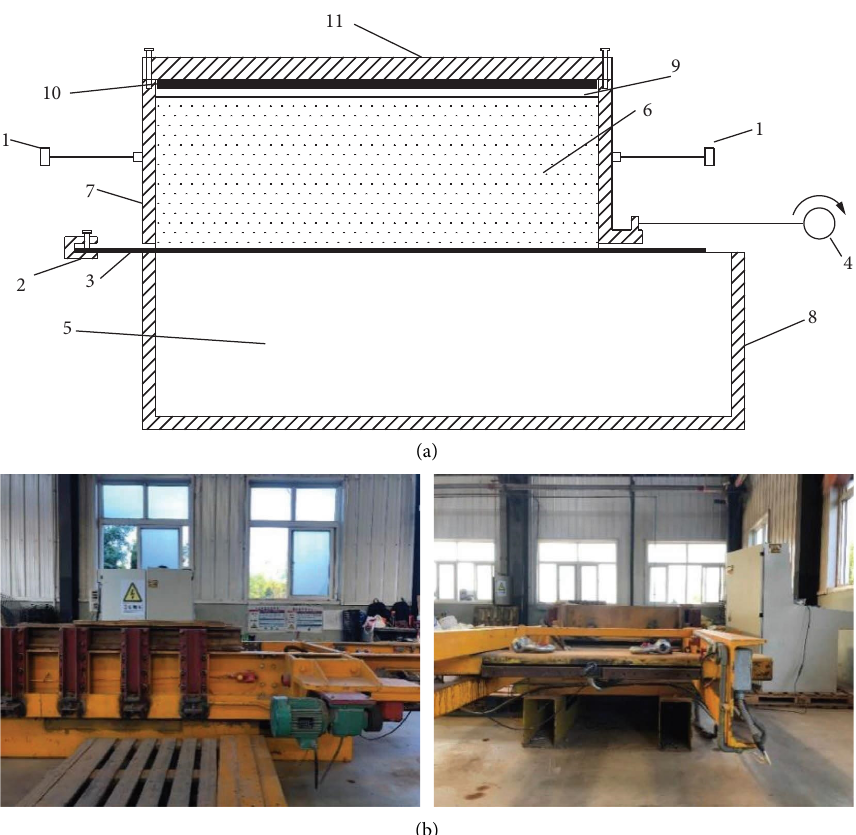
Figure 3: Direct shear apparatus. (a) Sectional view of shear boxes. (b) Object picture.